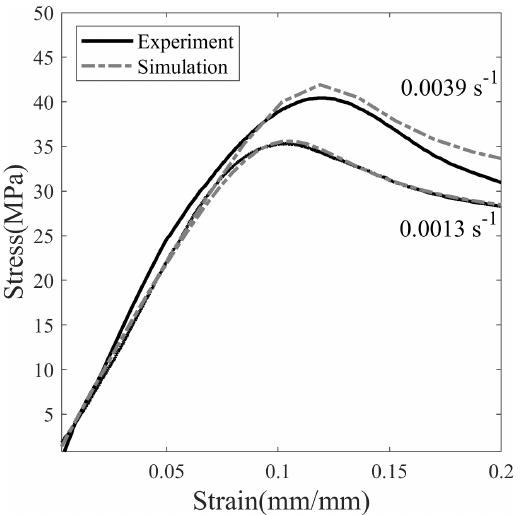
Figure 6. The stress–strain response of deformed SMP at strain rates of 0.0013 and 0.0039 s − 1 . Table 1. Material parameters of the constitutive model for shape memory polymers.